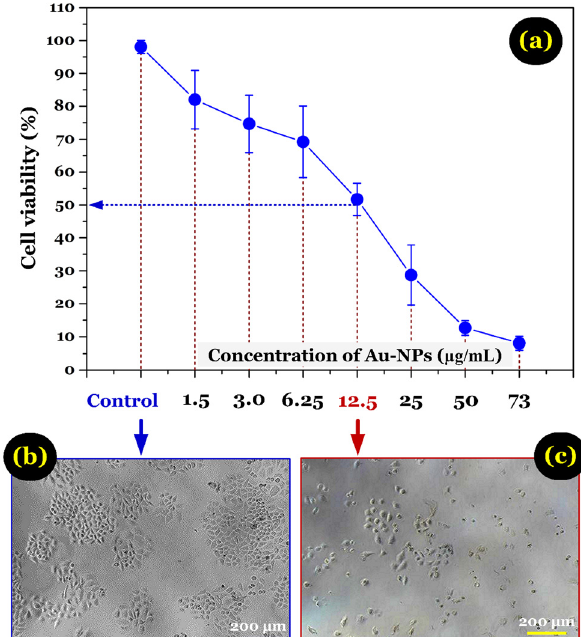
Figure 5: ( a ) E ff ect of the concentrations of Au - NPs - 3.75% on the viability of HeLa cells ( average ± SD; raw data presented in Table A1 ) ; microscopic images of HeLa cells without treated with Au - NPs - 3.75% ( b ) and after treated with Au - NPs - 3.75% ( 12.5 μ g/mL ) for 48h ( c )